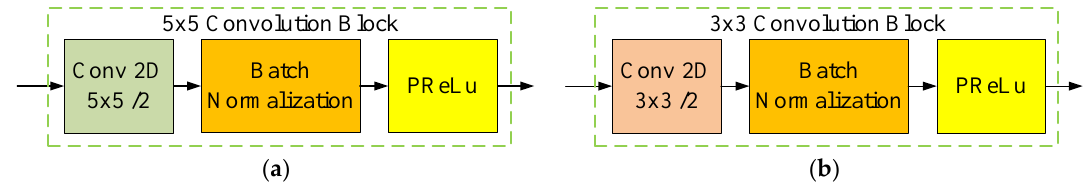
Figure 4. Comparison of the basic convolution block used in ( a ) SurfNet and ( b ) the proposed SurfNetv2.